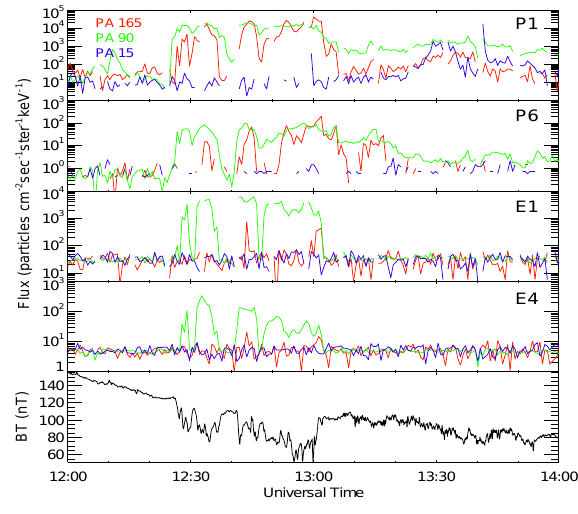
Fig. 8. The top four panels are proton and electron flux broken into PA (15 ◦ , 90 ◦ , 165 ◦ ), as measured by ISEE-1. The top two are proton flux at the lowest energy channel (P1, 22.5–39.0keV) and then the highest channel that shows a substantial increase in flux (P6, 210.0–333.0keV). The third and fourth panels from the top are electron flux in the lowest energy channel (E1, 22.5–39.0keV) and the highest channel to show a substantial flux increase (E4, 120– 189keV). The pitch angles are shown ±15 ◦ . The bottom panel is the strength of the local magnetic field measured by ISEE-1.